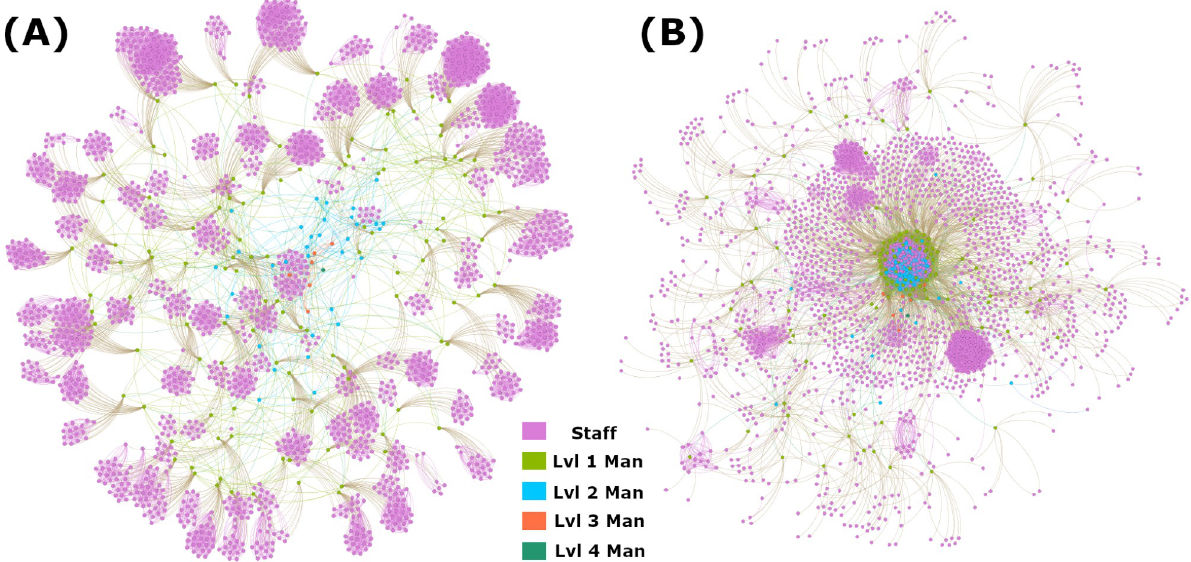
Fig 2. Empirical network visualizations. Nodes are color coded by layer: staff nodes are pink, level 1 managers are green, level 2 managers are light blue, level 3 managers are orange, and level 4 is dark blue. A: Visualization of the Line-Org network. B: Visualization of the Project network.